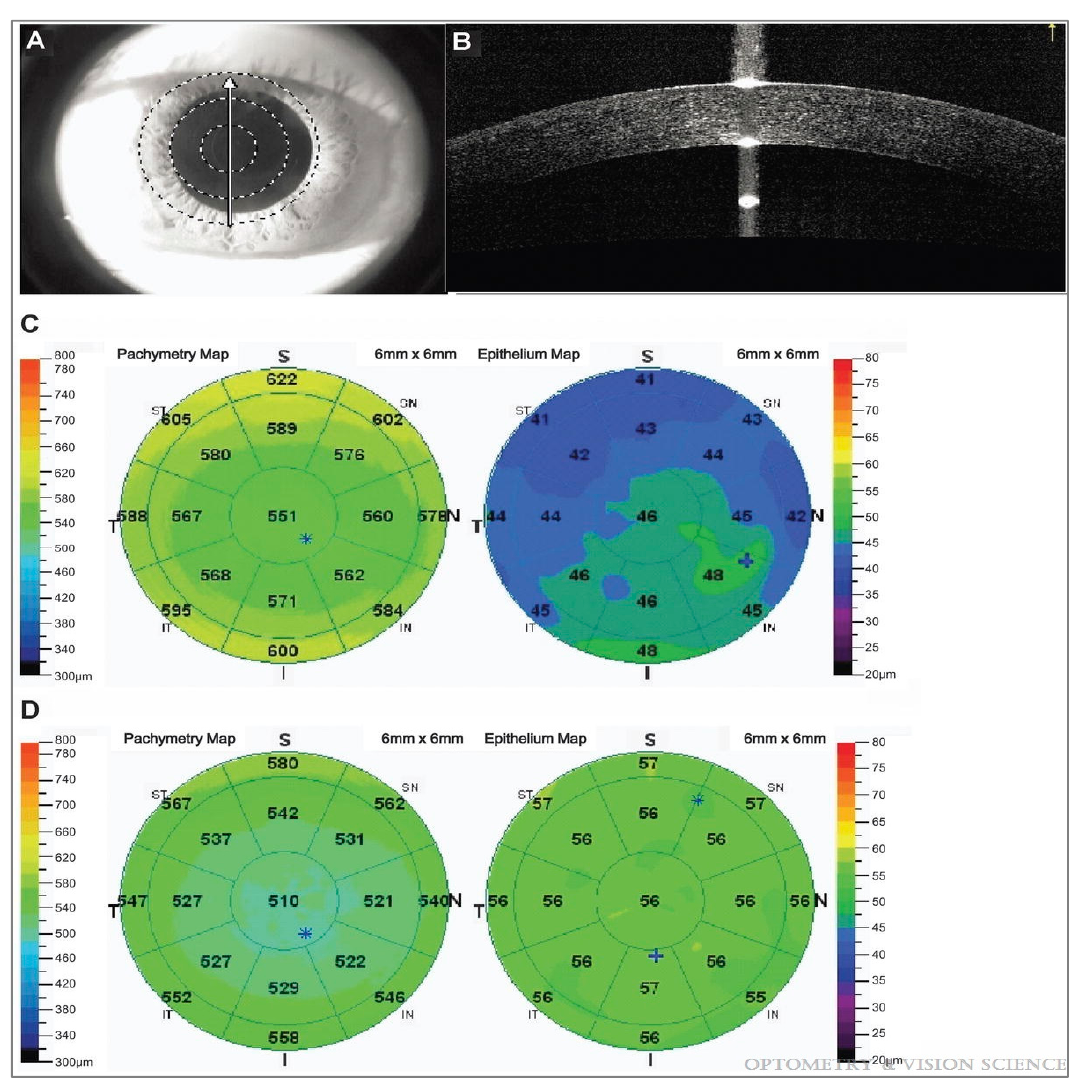
Figure 3. Central cornea’s field marked for pachymetry scan ( A ). Cross-section projection of cornea’s OCT image ( B ). Corneal total thickness maps and corneal epithelial thickness maps of a long-term contact lens user ( C ) and a non-CL wearer ( D ). Adapted from Hong et al. [40].